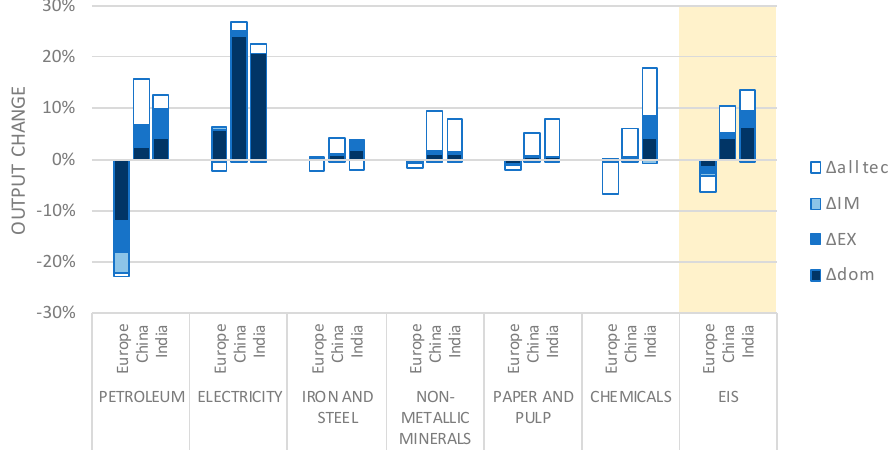
Figure 6. Sectoral and total output effects in energy intensive sectors in Europe, China and India in 2030 for low carbon technology scenario relative to baseline triggered by change in domestic demand ( Δ dom ), change in imports ( Δ IM ), change in exports ( Δ EX ), and deployment of low carbon technologies in other sectors ( Δ all tec ).